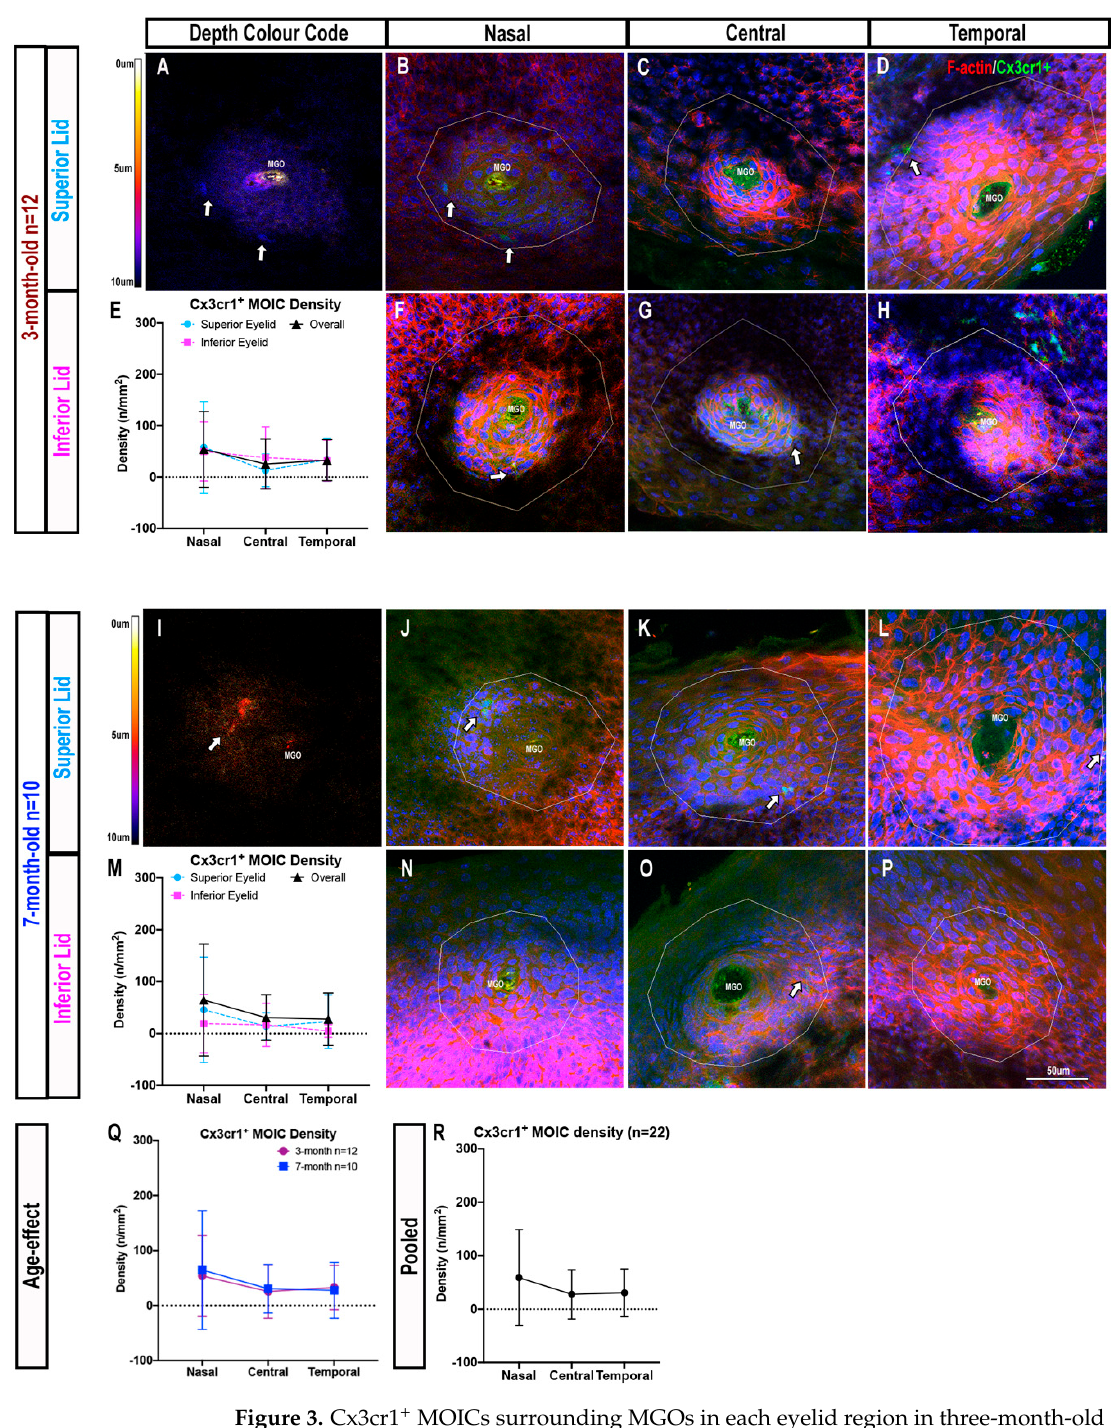
Figure 3. Cx3cr1 + MOICs surrounding MGOs in each eyelid region in three-month-old ( A – H ) and seven-month-old ( I – P ) mice. Depth colour code of Cx3cr1 + ICs surrounding an MGO in three- month-old ( A ) and seven-month-old ( I ) mice. Cx3cr1 + MOICs tend to be located deeper in the MG, and have shorter and fewer dendrites. Cx3cr1 + MOICs in the superior and inferior eyelids, three- month-old: ( B , F ) nasal, ( C , G ) central, ( D , H ) temporal; seven-month-old: ( J , N ) nasal, ( K , O ) central, ( L , P ) temporal. White arrows are Cx3cr1 + MOICs. Cx3cr1 + MOIC density across the superior and inferior lids in three-month-old ( E ) and seven-month-old ( M ) mice, and no effect of age on Cx3cr1 + MOIC distribution by eyelid region ( Q ). Overall Cx3cr1 + MOIC density distribution by region ( R ), pooling data from both age groups. All data are presented as mean ± SD. The same scale bar in ( P ) applies to all confocal images.